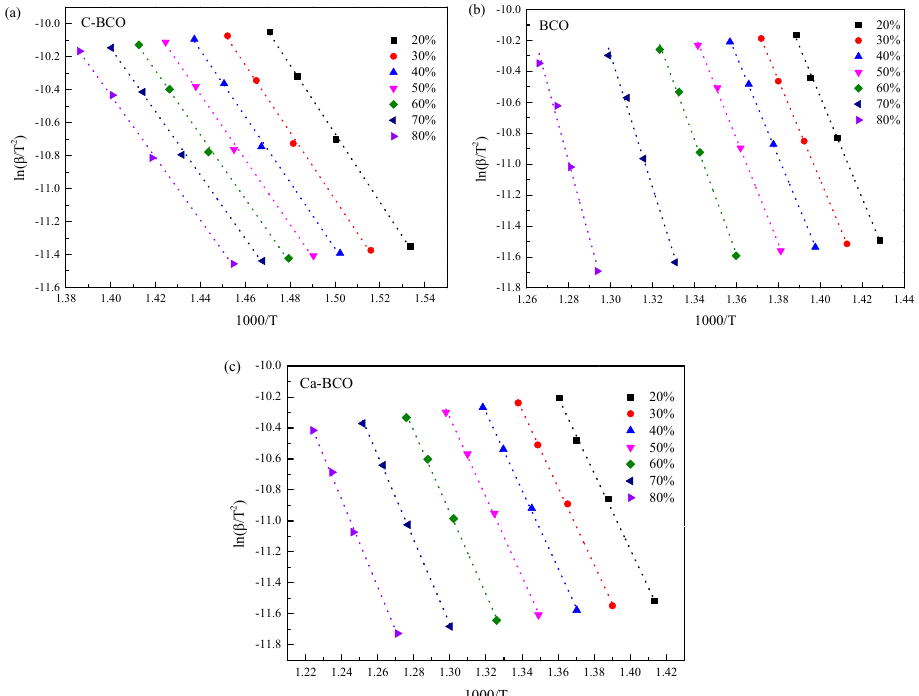
Figure 4. Plots of ln( β / T 2 ) versus 1000/ T at various mass losses of the first mass loss zone for as-prepared (BiO) 2 CO 3 nanowires ( a ) and Ca-(BiO) 2 CO 3 nanowires ( b ) based on the Kissinger–Akahira–Sunose method.